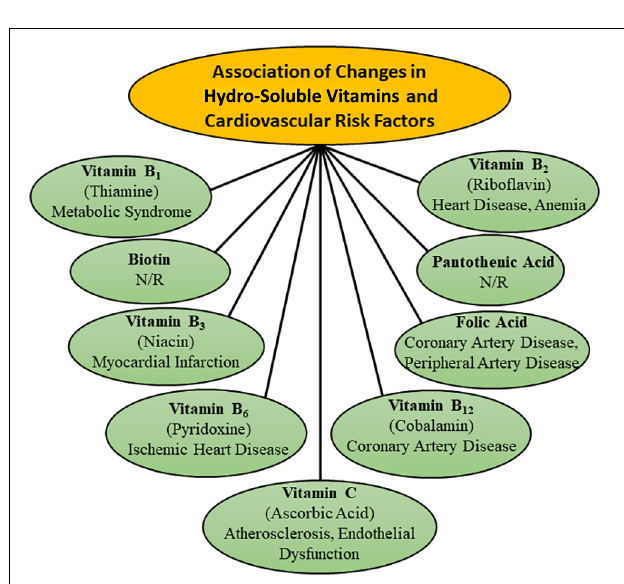
FIGURE 2 | Association of changes in plasma concentration of different hydro-soluble vitamins with various risk factors for the development of cardiovascular disease. N/R- not